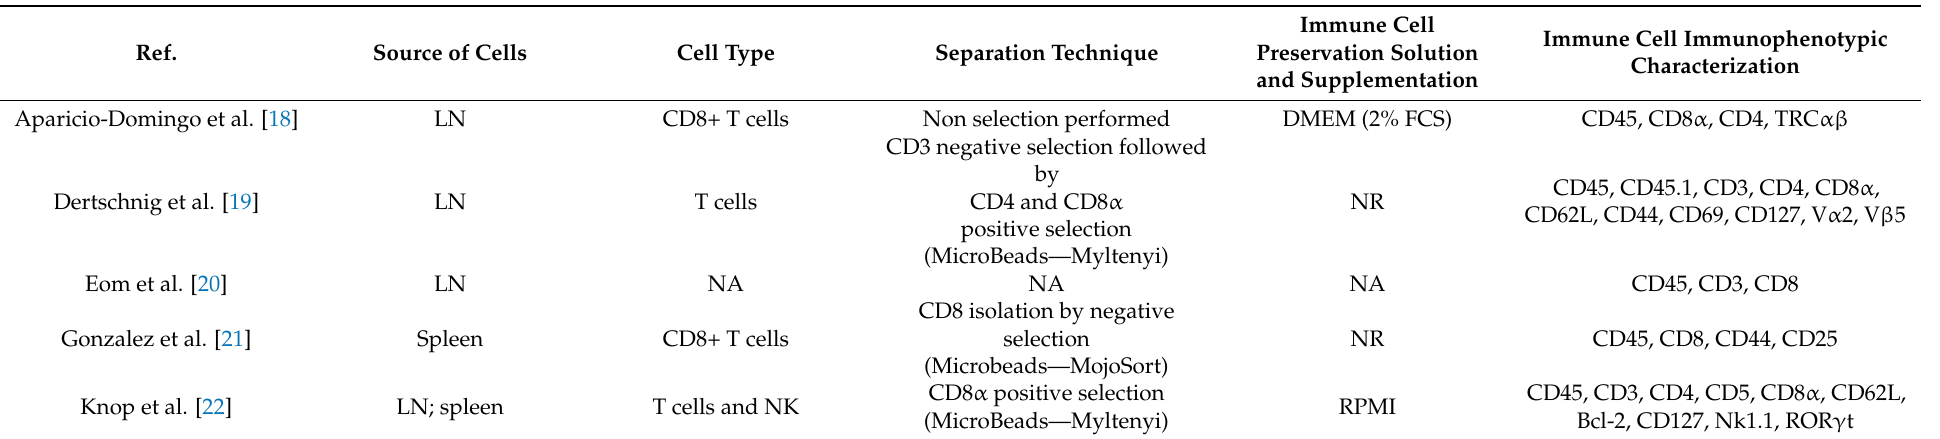
Table 3. Characteristics of the main type of immune cells used for analysis with fibroblastic reticular cells.